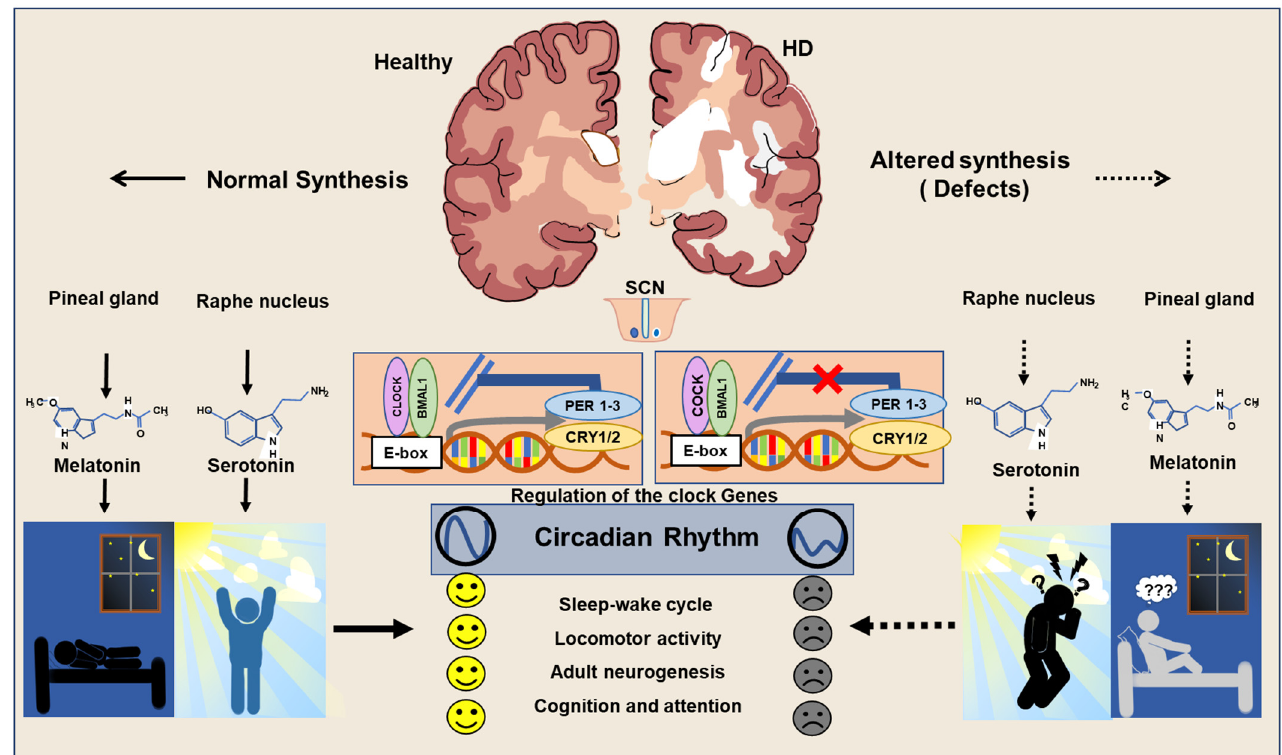
Figure 2. Regulation of circadian clock in Healthy and HD brains.